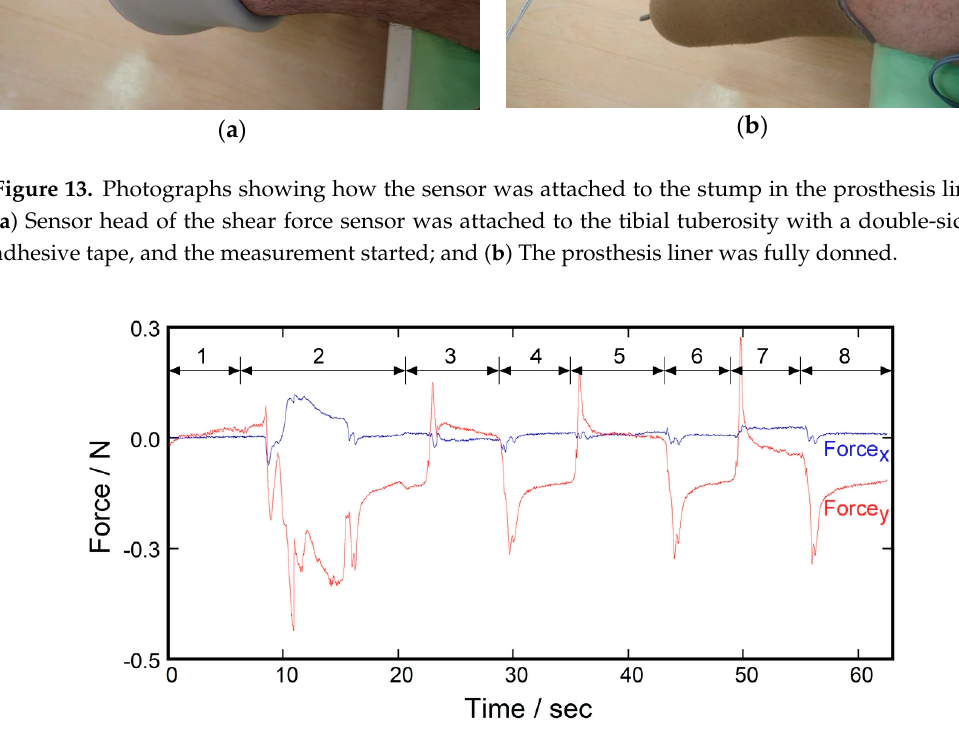
Figure 14. Time course of the measurement result of the prosthetic liner experiment using the shear force sensor. The test subject repeatedly flexed and extended their knee joint during the measurement: (1) Soon after the sensor attachment; (2) Donning the liner to fully cover the knee; (3) Flexion; (4) Extension; (5) Flexion; (6) Extension; (7) Flexion; and (8) Extension.